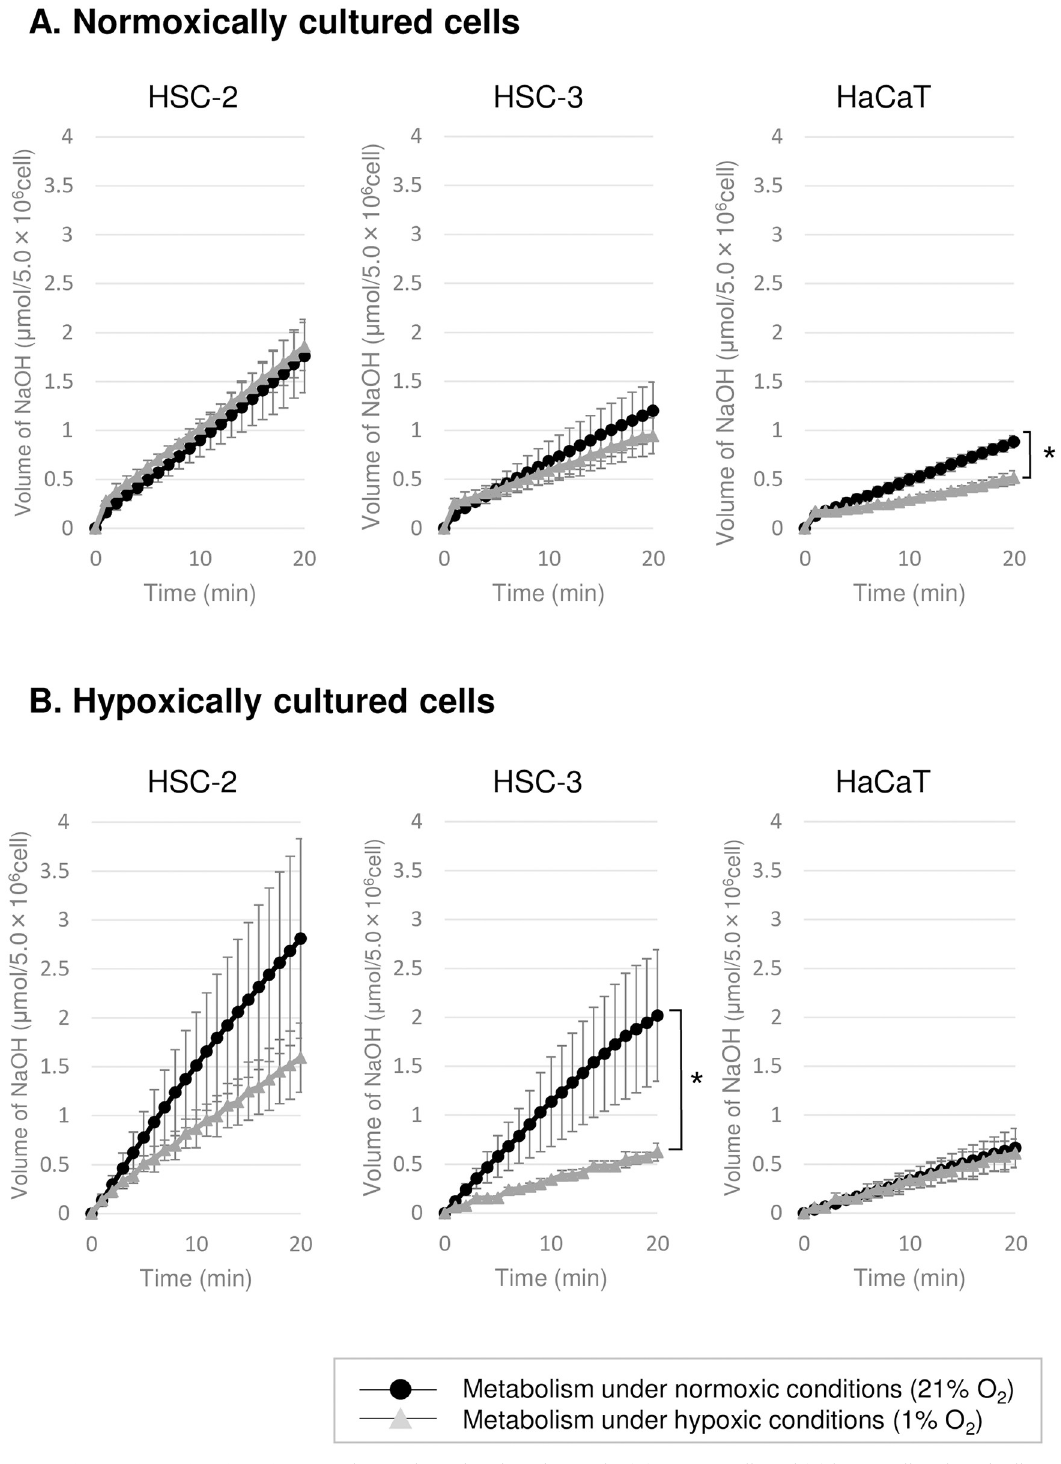
Fig 2. Glucose-derived acid production. Glucose-derived acid production by (A) normoxically and (B) hypoxically cultured cells was measured as the amount of NaOH added by the pH-stat system under normoxic or hypoxic conditions. Cancer cells were harvested after 3-day culture and normal cells were harvested after 5-day culture. The error bars represent standard deviation. Significant difference ( � , p < 0.05) between the normoxic and hypoxic conditions, according to the paired t-test.